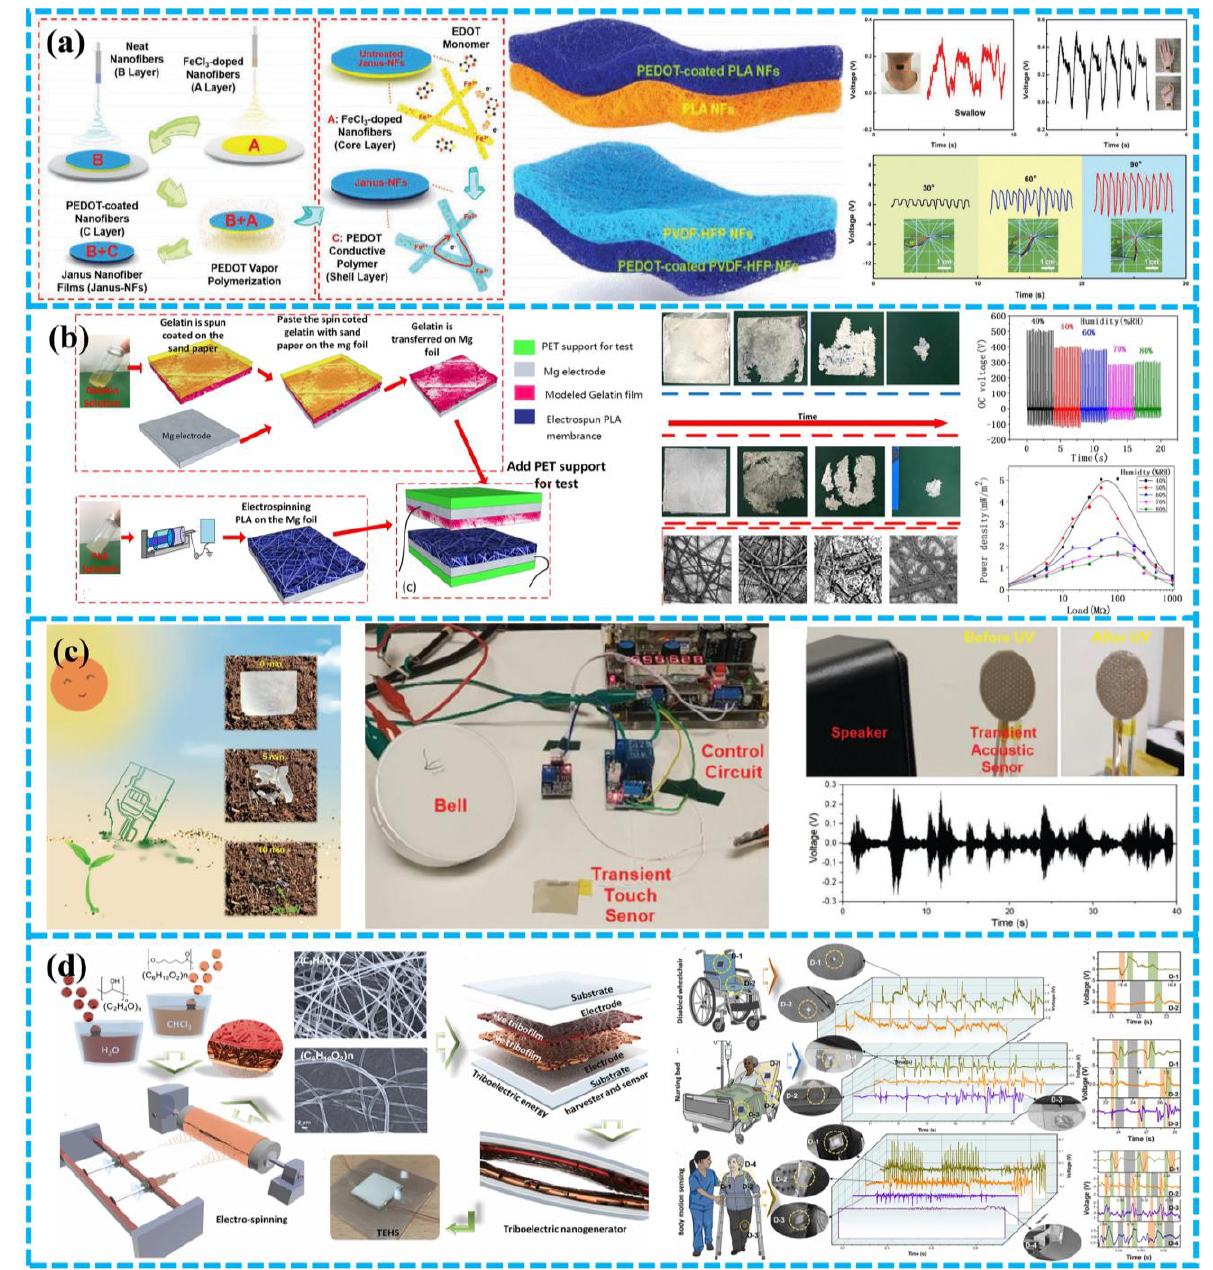
Figure 14. TENGs based on synthetic degradable polymers for self-powered sensing system. ( a ) A TENG based on crepe cellulose paper and nitrocellulose film for energy harvesting and self-powered human-machine interaction. Reproduced with permission [127], WILEY-VCH. ( b ) A full BD-TENG based on electrospinning polylactic acid and nanostructured gelatin film. Reproduced with permission [108], Copyright 2017, Elsevier Ltd. ( c ) A photothermal tunable biodegradable implantable TENG for tissue repair. Reproduced with permission [128], Copyright 2018, Elsevier Ltd. ( d ) A fully biocompatible and biodegradable triboelectric fiber membrane for triboelectric energy harvesters and sensors (THES). Reproduced with permission [129], Copyright 2022, Elsevier